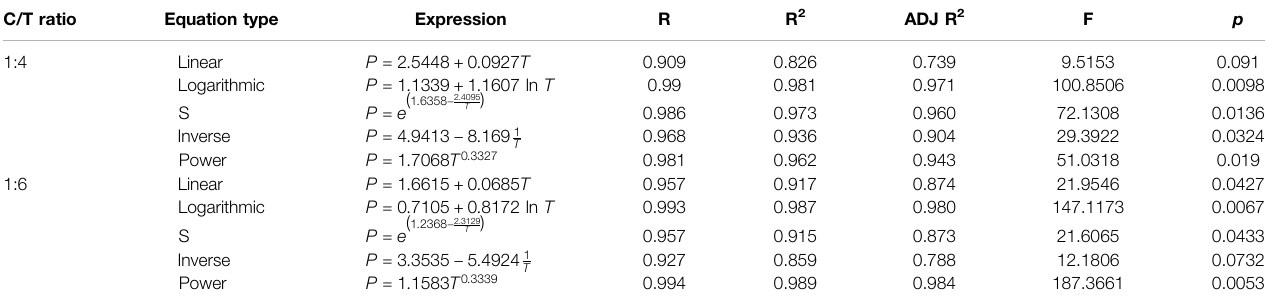
TABLE 3 | Regression equation and test